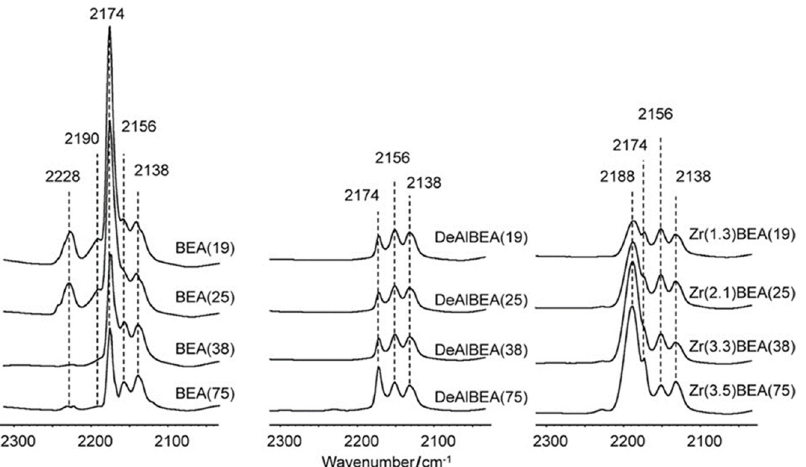
Figure 7. FTIR spectra of CO adsorption over the parent, dealuminated, and Zr incorporated dealuminated BEA zeolites. Reprinted with permission from [63]. Copyright 2016 WILEY-VCH Verlag GmbH & Co. KGaA, Weinheim.